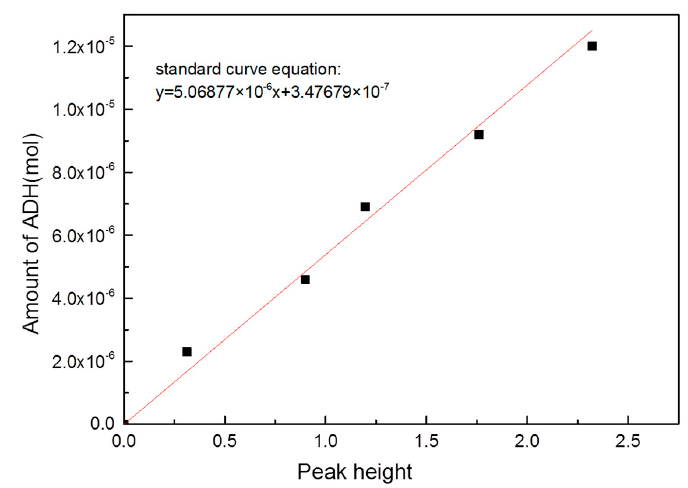
Figure 2. Peak values at approximately 3313 cm − 1 were regarded as a function of the –N–H concentration in hybrid films. The plot is used to determine the –N–H concentration or the amount of adipicdihydrazide (ADH) in the hybrid film after various reaction times of formaldehyde degradation.